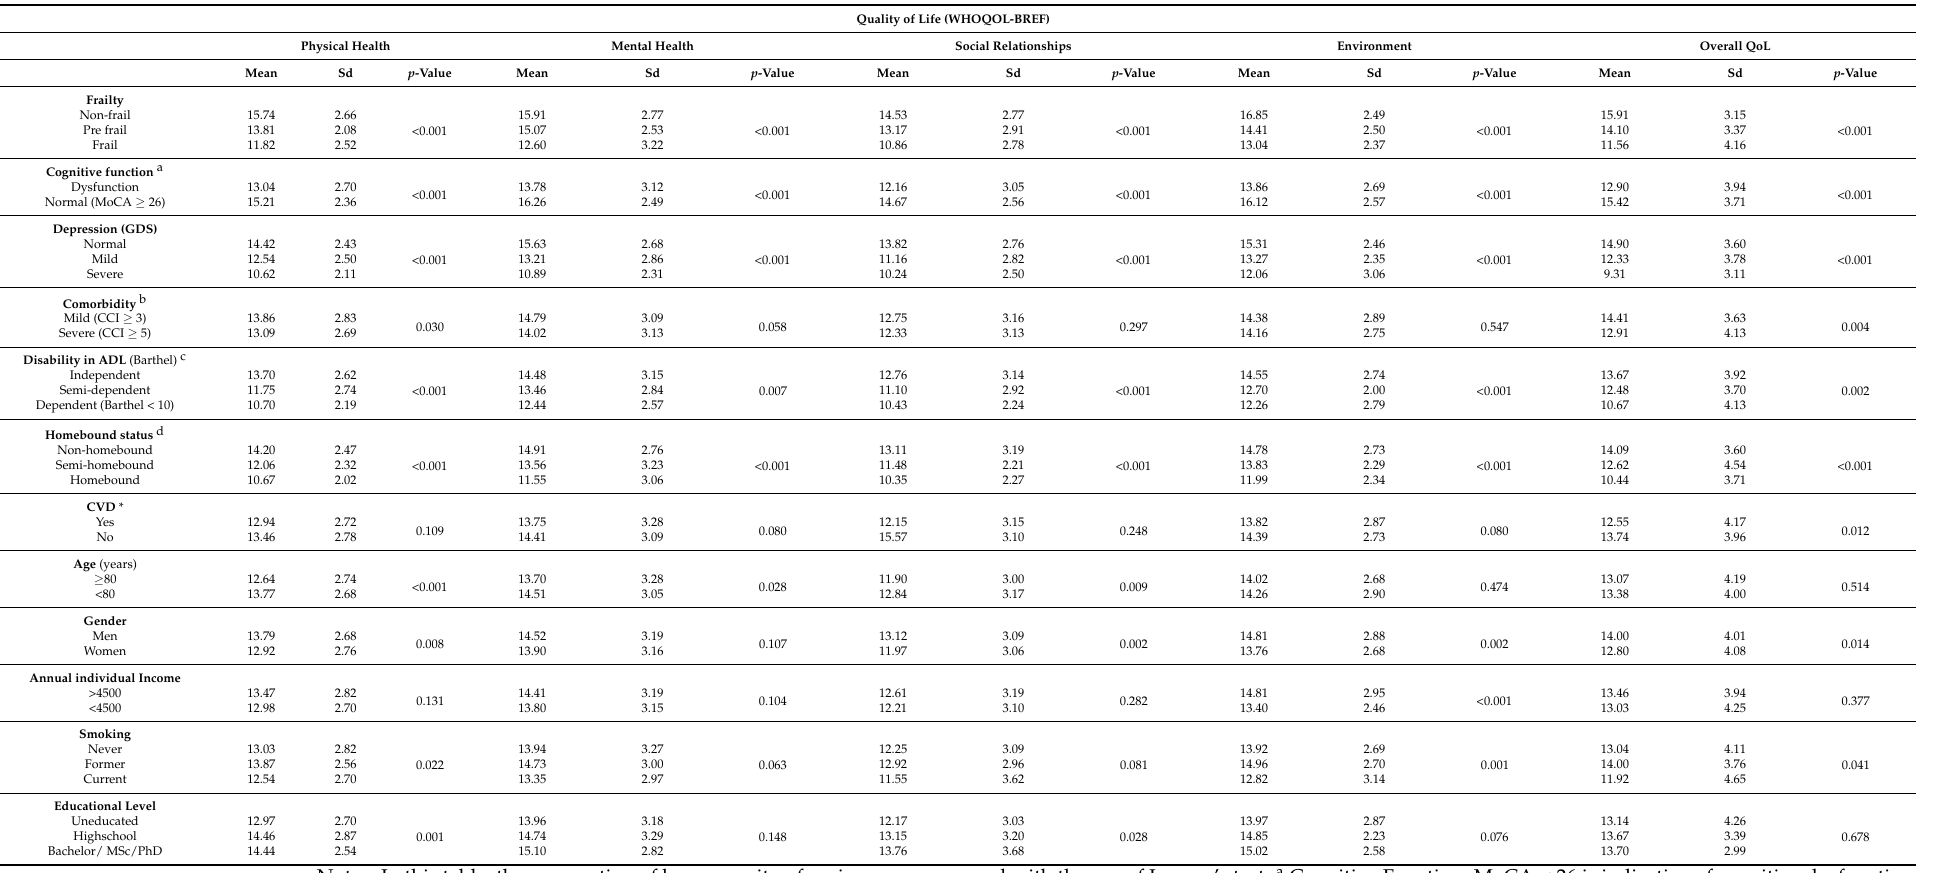
Table 2. Quality of Life differences (domain’s scores) with respect to frailty, geriatric syndromes, and socio-demographic variables (n =